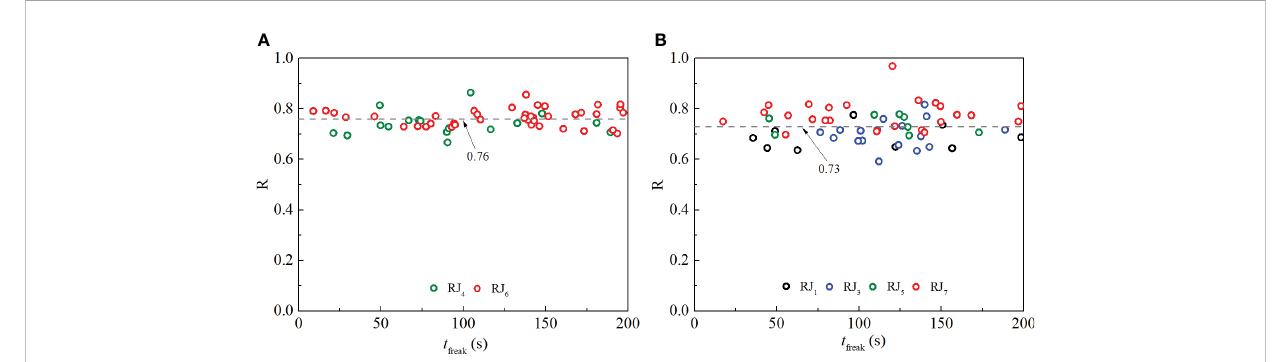
FIGURE 9 The ratio between the crest heights of the freak waves and the maximum wave heights for cases (A) with H s = 0.025 m and (B) with H s = 0.05 m, t freak is the occurrence time of the freak wave, the values of 0.76 and 0.73 are the average value for cases in (A, B) ,